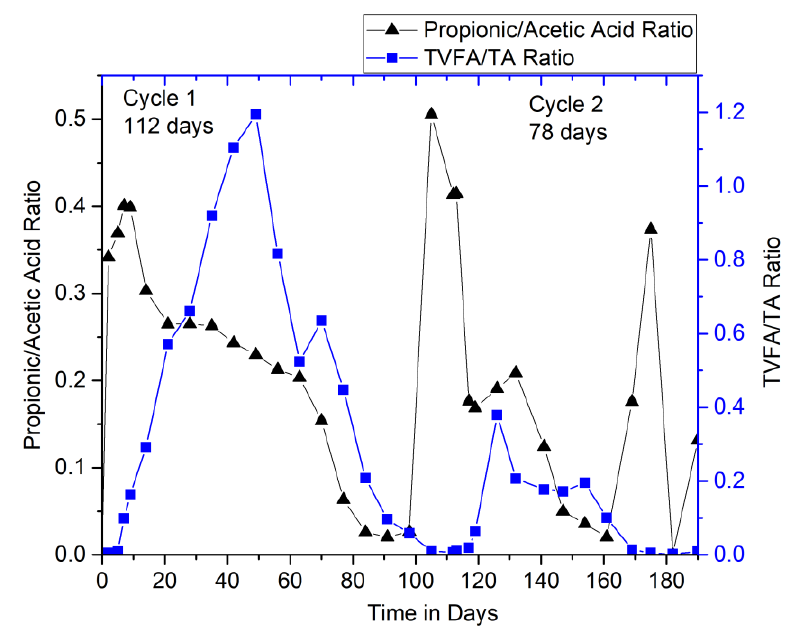
Figure 4. Evolution of TVFA/ TA and propionic acid/acetic acid ratios.